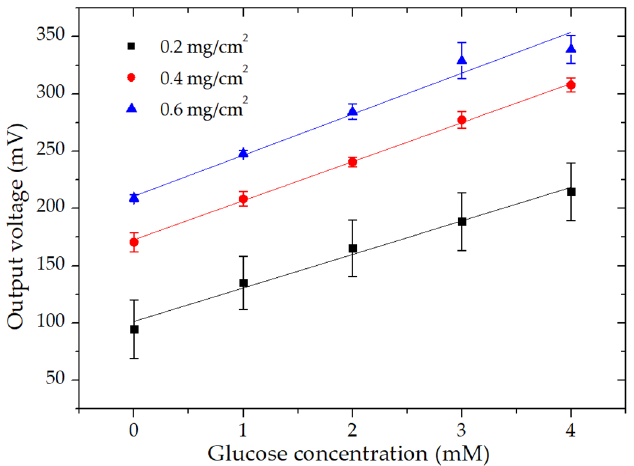
Figure 6. Linearity curves of the output voltage of the microfluidic EBFC as a function of glucose concentration for 0.2, 0.4, and 0.6 mg/cm 2 MWCNT deposition on electrodes at the current density of 100 µA.cm −2 and the flow rate of 3